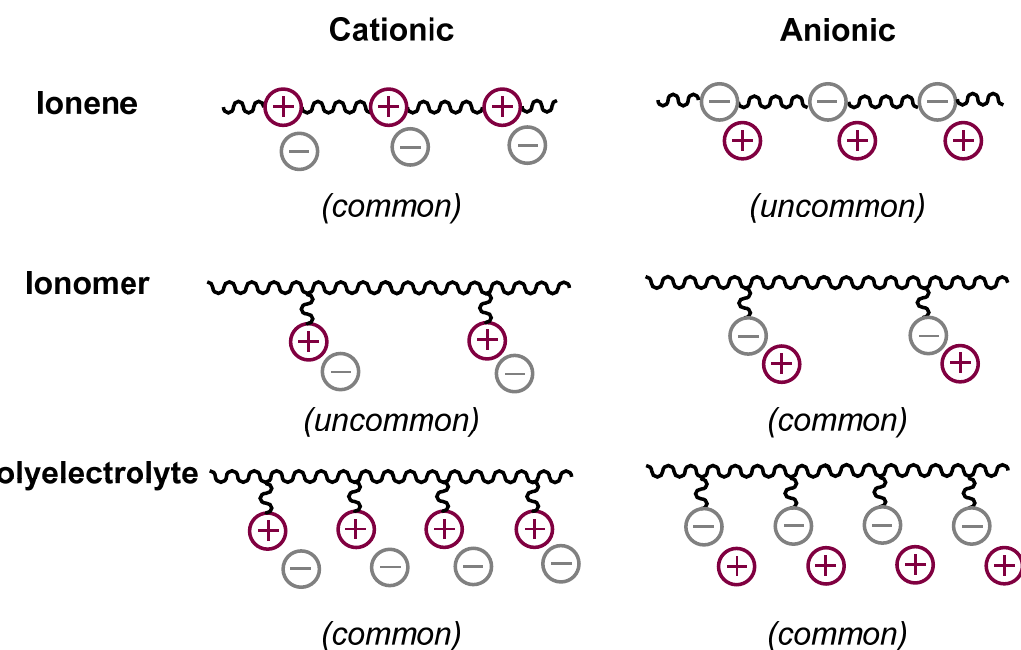
Figure 1. General representation of ionic polymer architectures, indicating their prevalence in literature.